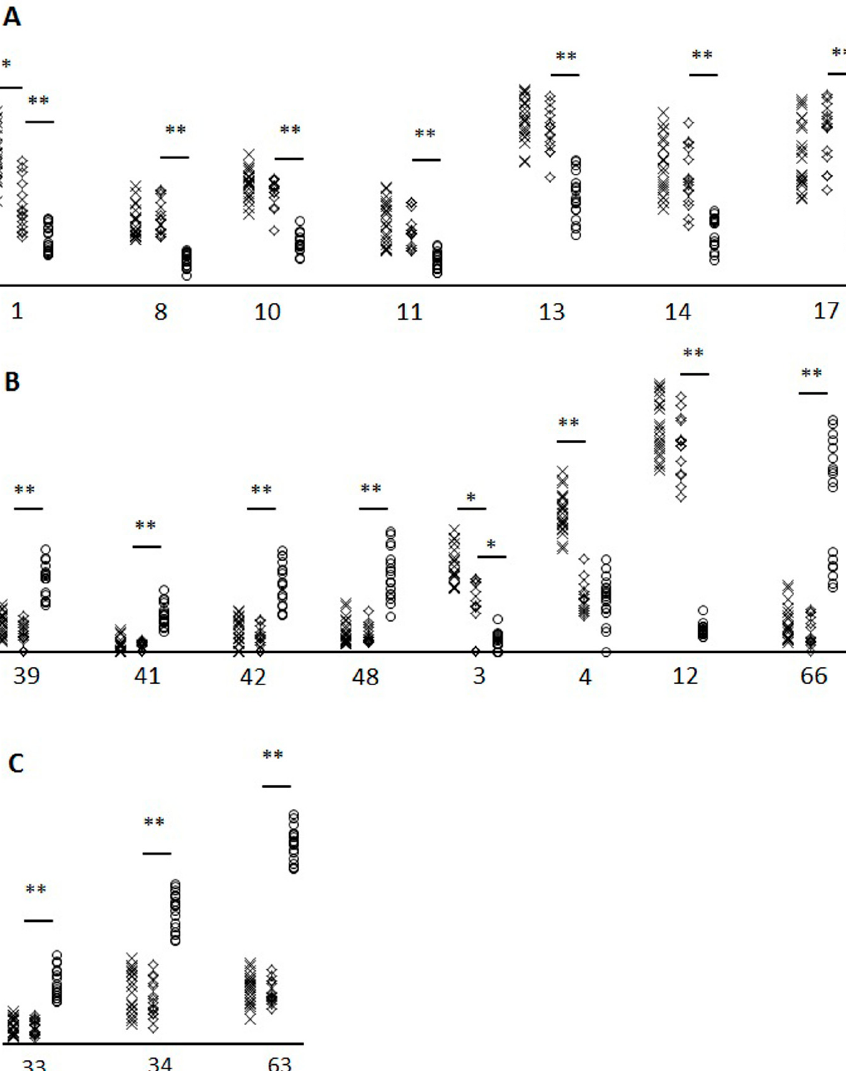
Figure 4. Results of the univariate statistical analysis identified metabolites with statistically significant differences among groups (negligible—( × ), gradual—( ♦ ) and rapid senescence—(O)). A.-metabolites related to a “group of amino acids” and a “group of biogenic amines” (alanine, valine, leucine, taurine, hypotaurine, and spermidine); B.-metabolites related to a “group of energy metabolism” (creatine, creatinine, carnitines, fumarate, malate, alpha-ketoglutarate, and citrate); C.-metabolites related to a “group of intermediates of sugar metabolism” (maltose, lactate, and pyruvate). The scatter plots show the intensity (relative units) of identified metabolites in the three compared groups. (**— p < 0.01; *— p < 0.05). Numbers are corresponded to ordinal metabolites numbers indicated in Table